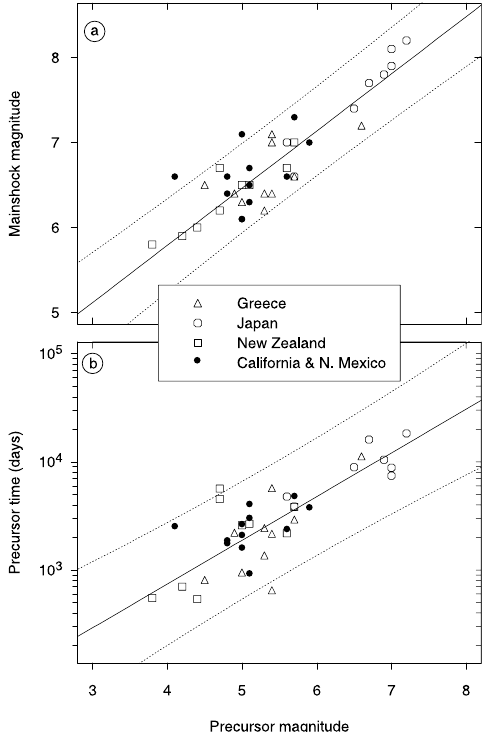
Fig. 4a,b. Predictive regressions (after Evison and Rhoades, 2000) obtained from systematic studies in Greece, Japan and New Zealand, with California and Northern Mexico data superimposed. a) Mainshock magnitude versus precursor magnitude. b) Precursor time versus precursor magnitude. NB : Precursor magnitude and precursor time refer to the special case of the swarm precursor for the Greece, Japan and New Zealand data, and to the more general (cid:115) -precursor for the California and Northern Mexico